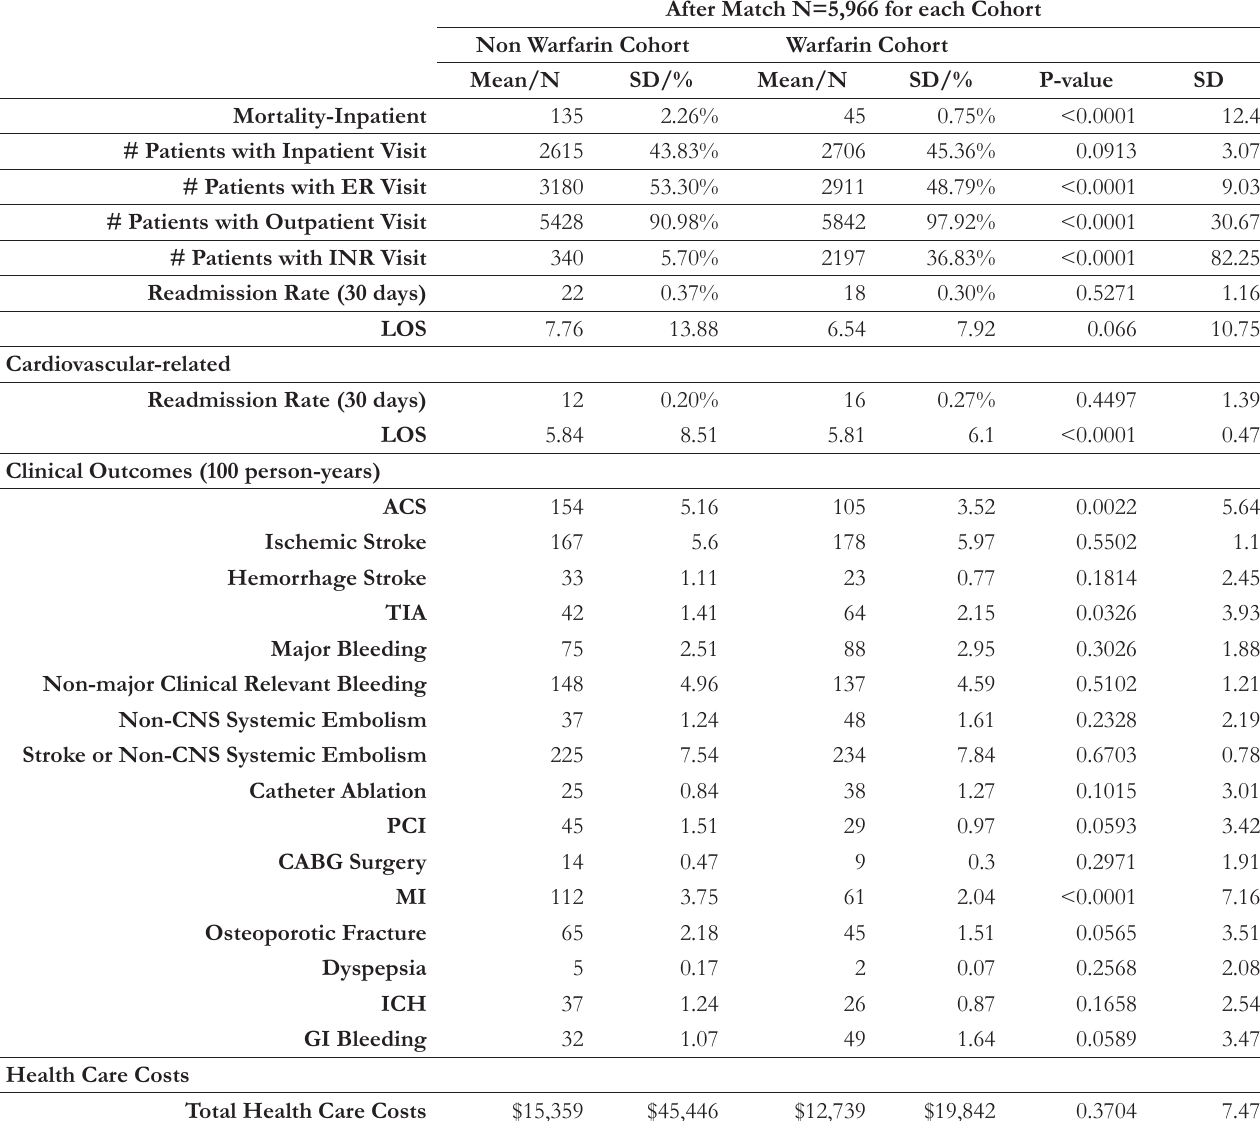
Table 5. Risk-adjusted Outcomes for NVAF Patients Prescribed Warfarin or Not